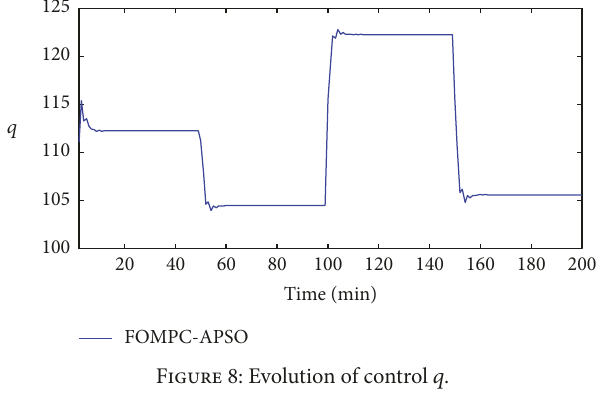
Figure 8: Evolution of control 𝑞 .